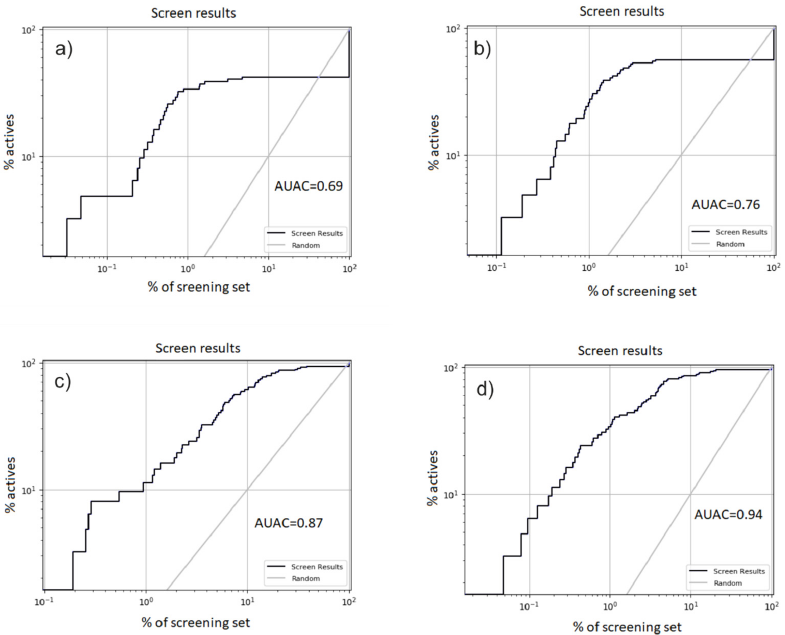
Figure 5. ROC curves of four docking results. ( a ) The first set: Grid-1—docking effort level 1. Area under accumulation curve: 0.69. ( b ) The second set: Grid-2—docking effort level 1. Area under accumulation curve: 0.76. ( c ) Grid-1—docking effort level 5. Area under accumulation curve: 0.87. ( d ) Grid-2—docking effort level 5. Area under accumulation curve: 0.94.